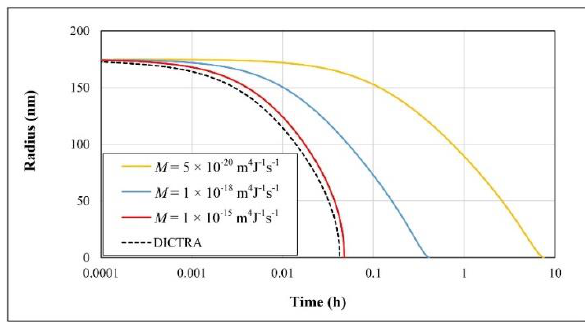
Figure 10. Time evolution of the radius of a spherical θ -Al 2 Cu precipitate dissolving in a finite Al-1.0 at%Cu matrix at 730 K with three different values for the interfacial mobility. The number density of the precipitates is assumed to be 1.0 × 10 18 m -3 .